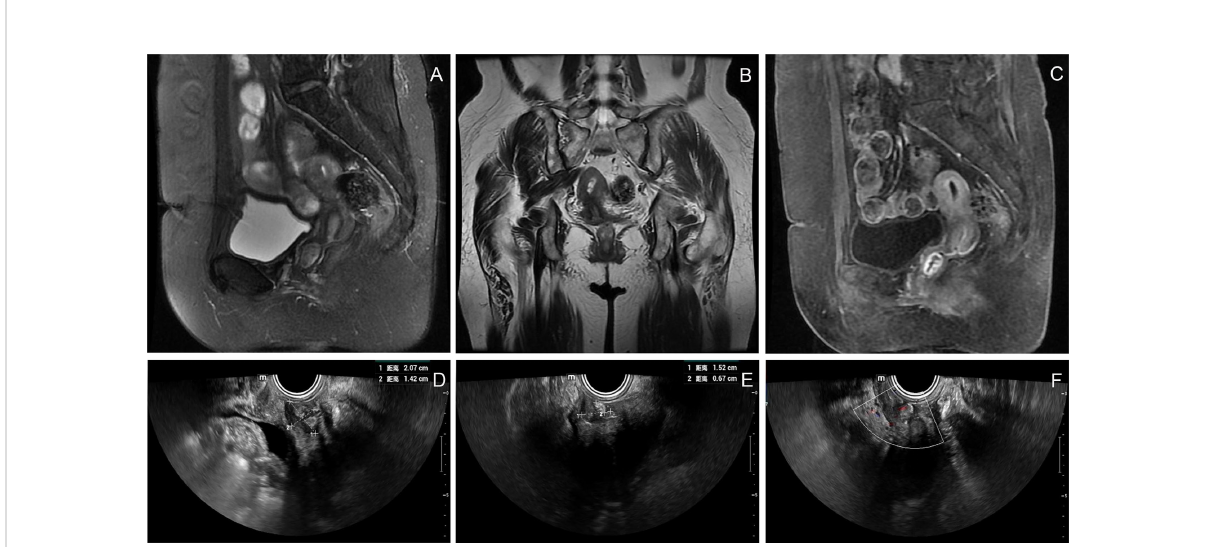
FIGURE 1 Imaging and ultrasound fi ndings of the patient. (A – C) Pelvic enhancement MR: an oval equal T1 mixed T2 signal shadow was observed on the anterior wall of the upper segment of the vagina, approximately 1.7 cm × 1.4 cm × 1.9 cm, with obvious ring reinforcement; (D – F) Pelvic ultrasound: a 2.1 cm × 1.5 cm × 1.4 cm mass was observed on the anterior wall of the vagina, with a fuzzy boundary and a hypoechoic inside with multiple strong echoes. CDFI could detect blood fl ow